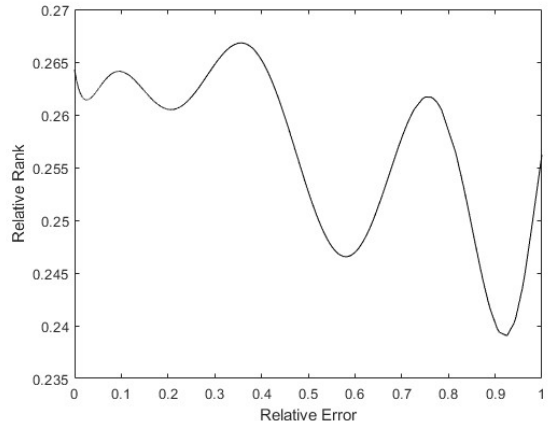
Figure 38. Polynomial regression of relative rank to relative error on X 2 .